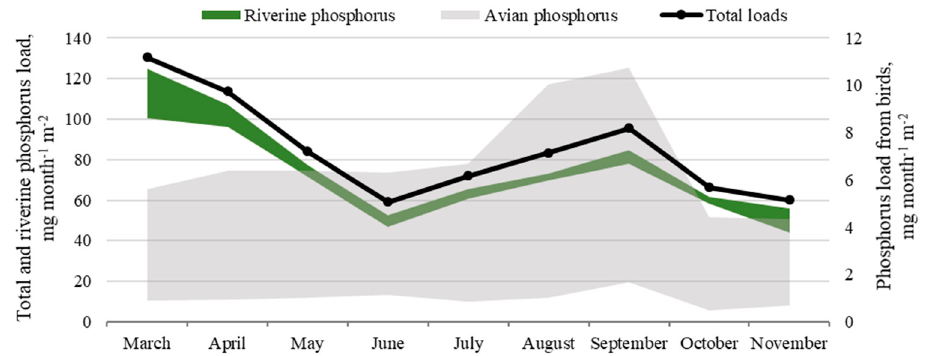
Figure 4. Monthly comparison of the P loads from the Nemunas River and those associated to aquatic birds excretion in the period March–November 2018 in the Curonian Lagoon.